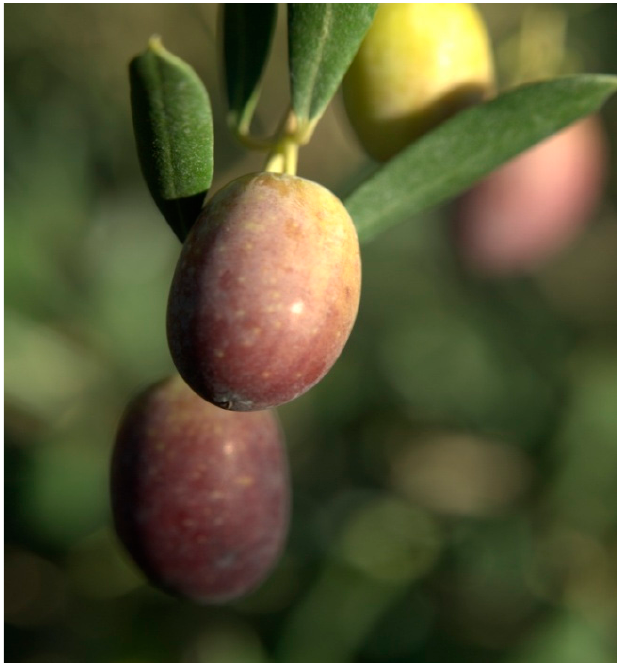
Figure 8. Olives of ‘Lecciana’ at the optimal ripening phase to harvesting, around 200 days after full bloom.